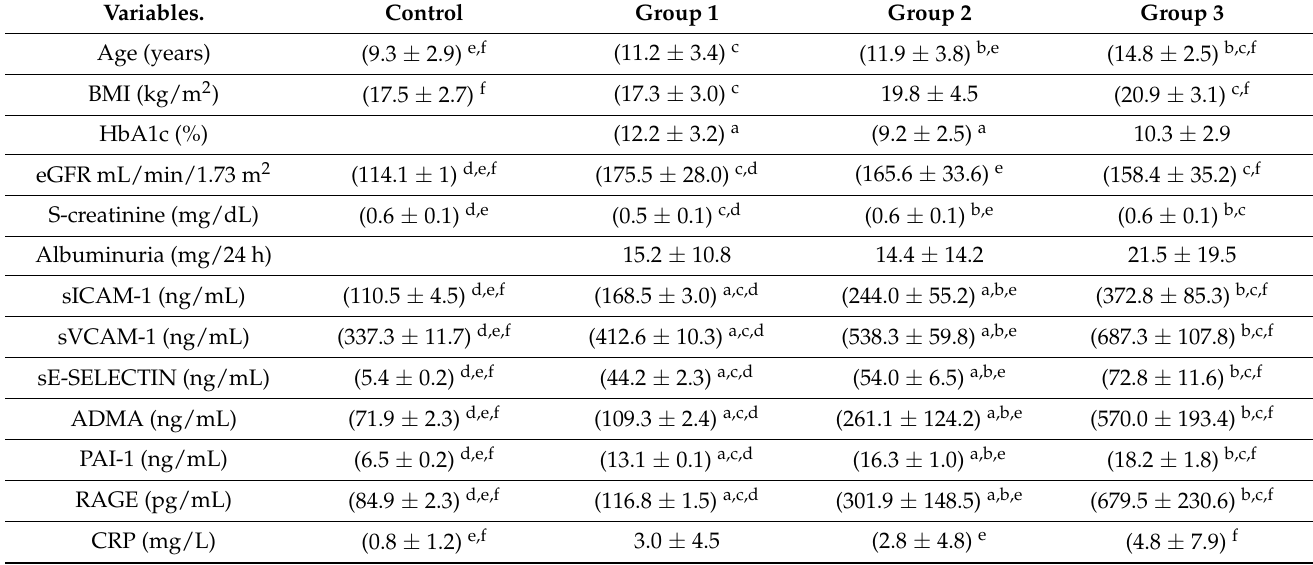
Figure 1. ( a – g ). A comparison of the distribution of selected parameters vs. DM1 duration. Boxplot of values for each subgroup. (( a )—the mean sICAM-1 values: 110.48 ± 4.53 vs. 168.47 ± 3.05 vs. 243.97 ± 55.18 vs. 372.85 ± 85.31 ng/mL; ( b )—the mean sVCAM-1 values: 337.33 ± 11.73 vs. 412.56 ± 10.29 vs. 538.29 ± 59.77 vs. 687.26 ± 107.84 ng/mL; ( c )—the mean sE-SELECTIN values: 5.43 ± 0.21 vs. 44.17 ± 2.27 vs. 54.01 ± 6.5 vs. 72.84 ± 11.56 ng/mL; ( d )—the mean ADMA values: 71.91 ± 2.31 vs. 109.32 ± 2.38 vs. 261.05 ± 124.20 vs. 569.99 ± 193.44 ng/mL; ( e )—the mean PAI-1 values: 6.51 ± 0.21 vs. 13.07 ± 0.11 vs. 16.29 ± 1.04 vs. 18.21 ± 1.84 ng/mL; ( f )—the mean RAGE values: 84.94 ± 2.27 vs. 116.78 ± 1.53 vs. 301.95 ± 148.48 vs. 679.45 ± 230.59 pg/mL; and ( g )—the mean CRP values: 0.8 ± 1.2 vs. 2.97 ± 4.53 vs. 2.78 ± 4.77 vs. 4.82 ± 7.92 mg/L). Legends: Control—control group; 1—the patients with newly diagnosed diabetes mellitus (DM1 duration < 1 year), n = 19; 2—the patients with DM1 duration of 1–5 years, n = 24; 3—the patients with DM1 duration of at least 5 years, n = 23. Table 2 lists the data based on DM1 duration (Group I, II, III) and the control group (Control). Table 2. Demographic, clinical, and biochemical data of the groups depending on DM1 duration Legends: Control—con- trol group; Group 1—the patients with newly diagnosed diabetes mellitus (DM1 duration < 1 year), n = 19; Group 2—the patients with DM1 duration of 1–5 years, n = 24; Group 3—the patients with DM1 duration of at least 5 years, n = 23. a : difference between group I and II is significant ( p < 0.05), b : difference between Group II and III is significant ( p < 0.05), c : difference between Group I and III is significant ( p < 0.05), d : difference between Control group and Group I is significant ( p < 0.05), e : difference between Control group and Group II is significant ( p < 0.05), f : difference between Control group and Group III is significant ( p < 0.05).